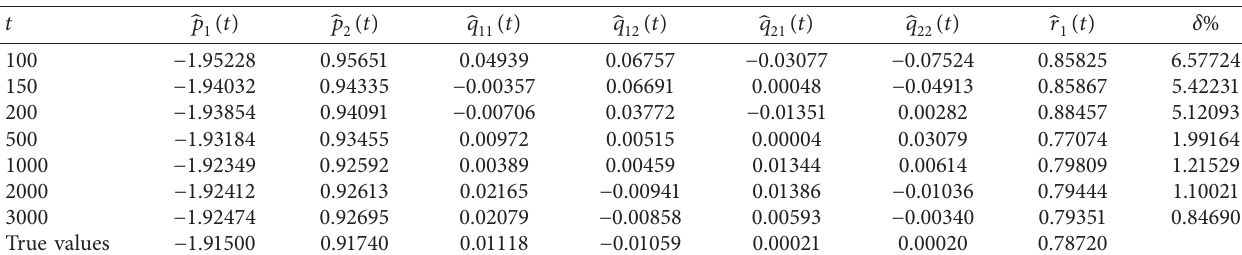
Table 5: The parameter estimates and their errors with clustering inputs based recursive least squares algorithm ( σ 2 � 0 . 40 2 )